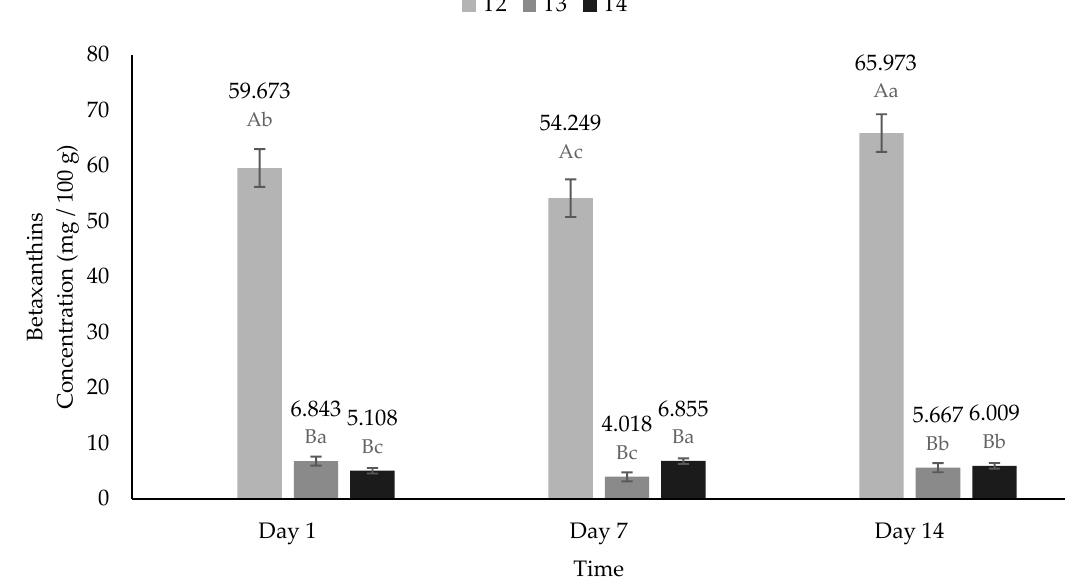
Figure 8. Betaxanthins content of yogurt added with beet extract. T2 = Y added with beet juice, T3 = Y added with extract encapsulated with Maltodextrin, and T4 = Y added with extract encapsulated with Inulin. A,B Values with different superscript indicate significant statistical difference between treatments ( p < 0.05). a,b,c Values with a different superscript indicate significant statistical difference over time ( p < 0.05).